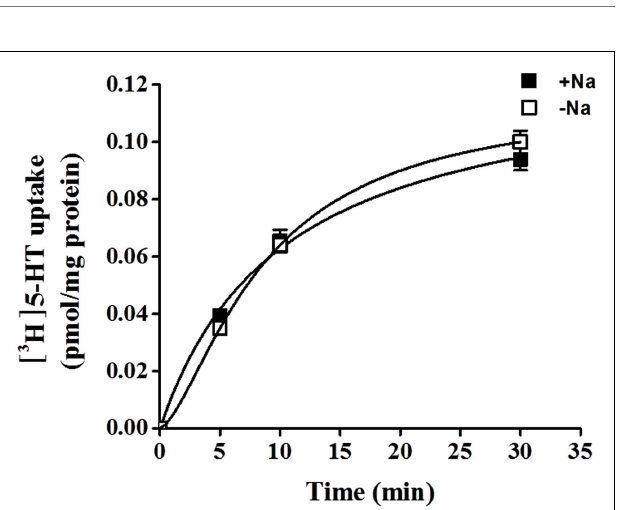
FIGURE 1 |Time-course of 5-HT uptake in HBVSMCs. [ 3 H]5-HT uptake (1 µ M, 2 µ Ci/mL) was measured in HBVSMCs in the presence or absence of Na + as indicated.Values are means ± SEM of three experiments carried out in triplicate.